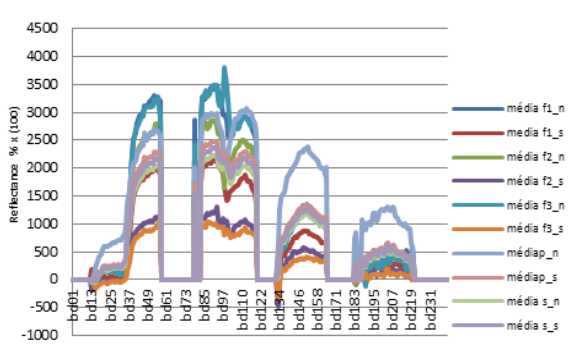
Figure 7. Reflectance of different vegetation